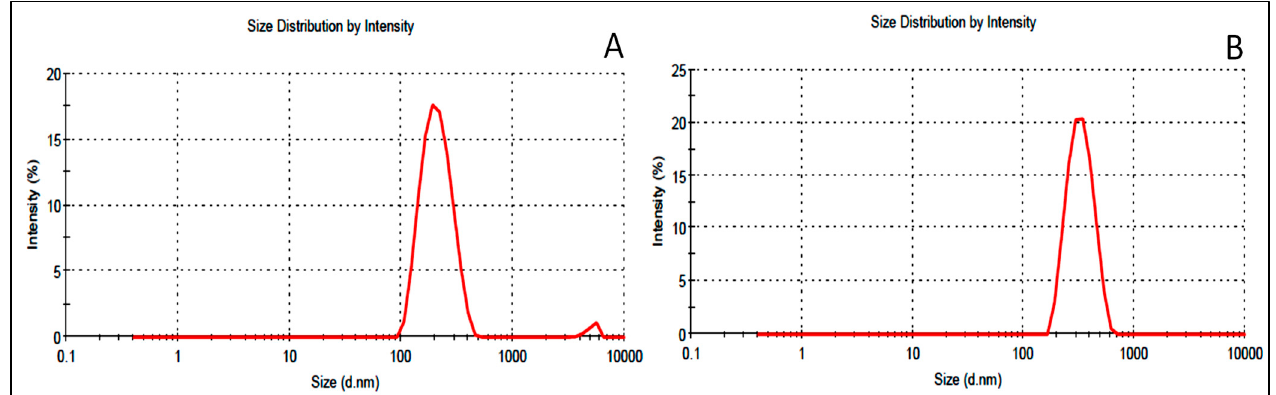
Figure 2. Vesicle size ( A ) apigenin bilosomes (F2) and ( B ) chitosan-coated apigenin bilosomes